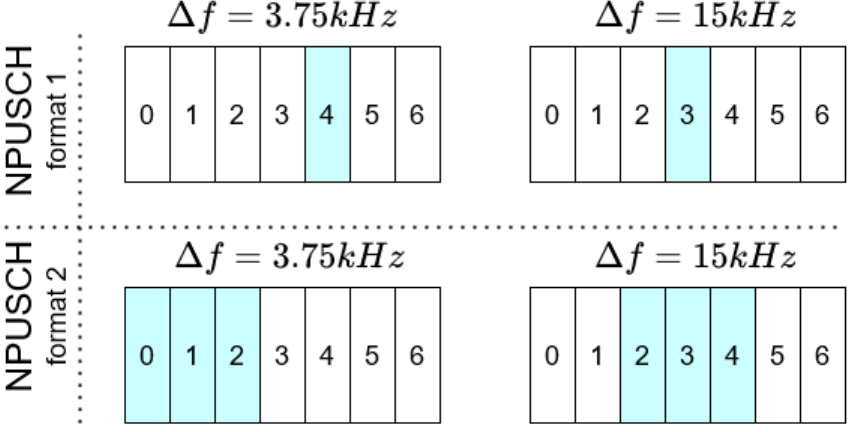
Figure 6. DMRS allocation